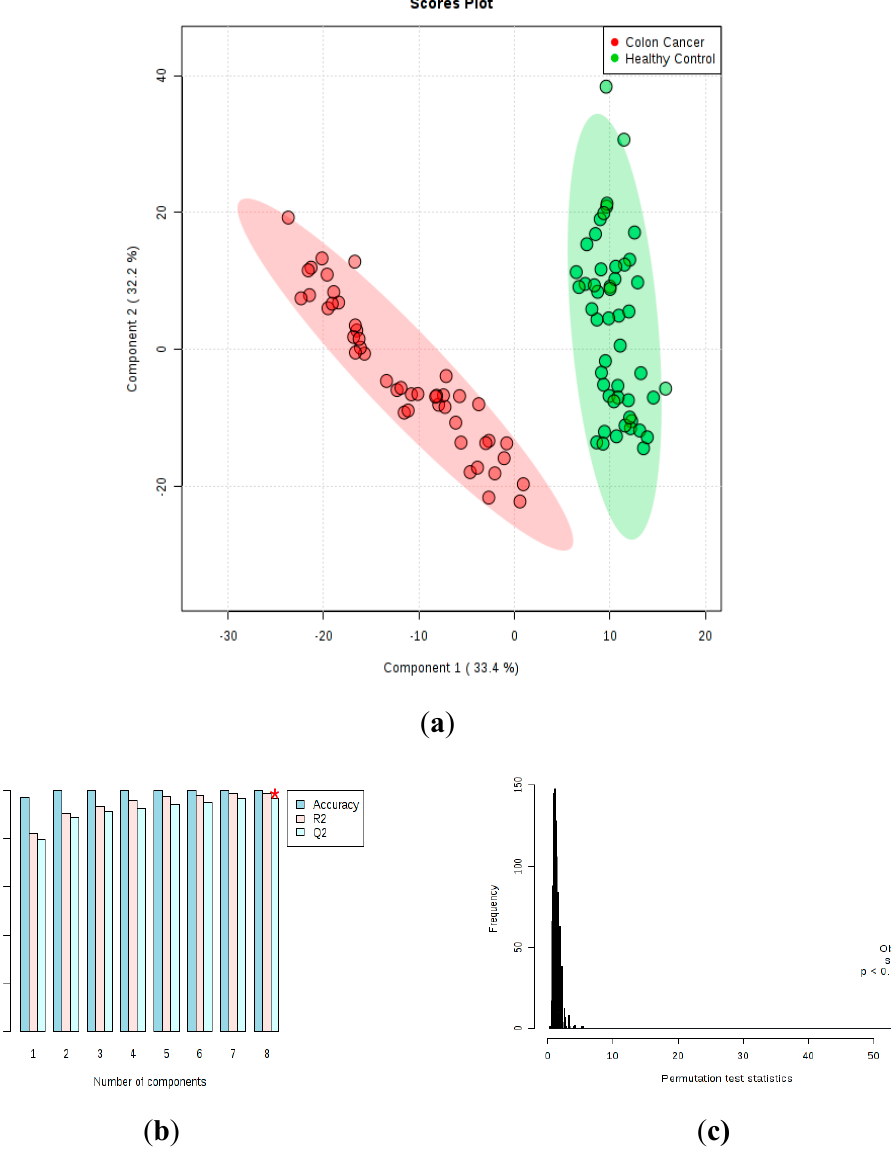
Figure 1. Partial least squares discriminant analysis (PLS-DA) scores plot for control (CTR) volunteers (green) and colon cancer (CC) patients (red). ( a ) As shown, 33.4% and 32.2% of the variance of the samples are explained by components 1 and 2, respectively. ( b ) Performance measures of the PLS-DA model (prediction accuracy, R2, and Q2), *best value of Q2 (0.97). ( c ) Permutation test at 1000 permutations ( p < 0.001).